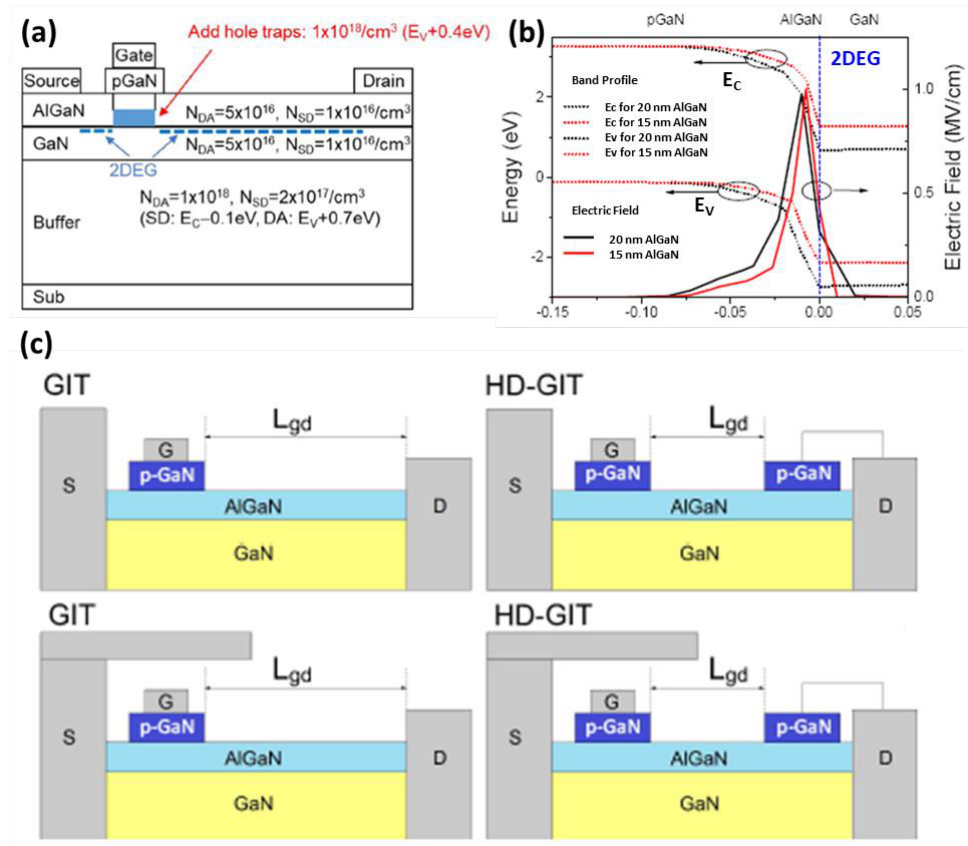
Figure 10. ( a ) Schematic cross-section of gate injection transistor (GIT). The densities and levels of traps employed in simulation in this study are also presented. ( b ) Energy band profiles underneath the pGaN gate simulated for the GIT with a thinner (15-nm-thick) AlGaN (larger V TH ) and a thicker (20-nm-thick) AlGaN barrier (smaller V TH ). ( c ) Schematic cross sections of a gate injection transistor (GIT) and a hybrid-drain-embedded GIT (HD-GIT) without and with the field plate [164,165]. Figure reproduced with permission from IEEE Proceedings.